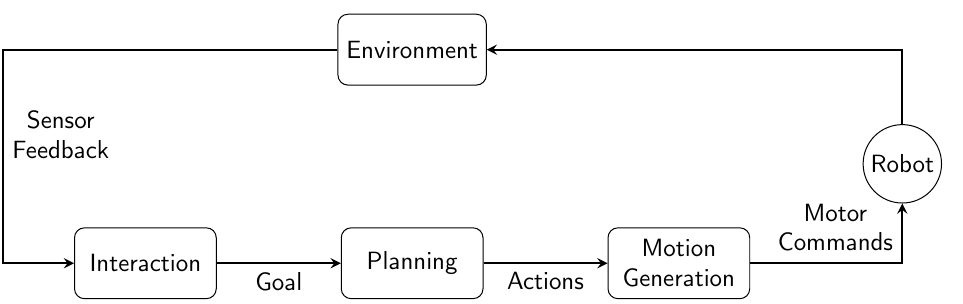
Figure 6. Scheme of the different layers of a generic human-robot interaction